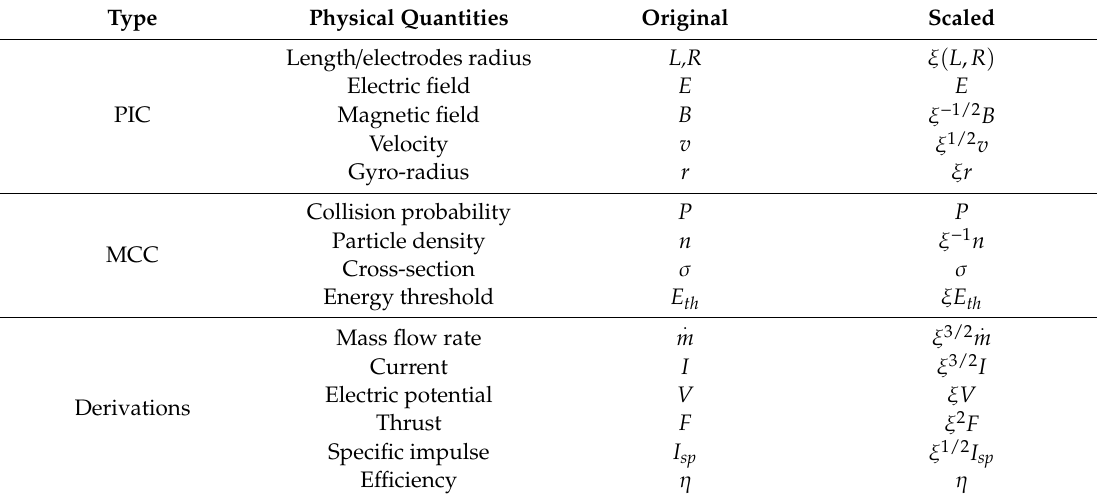
Table 3. The scaling schemes of di ff erent